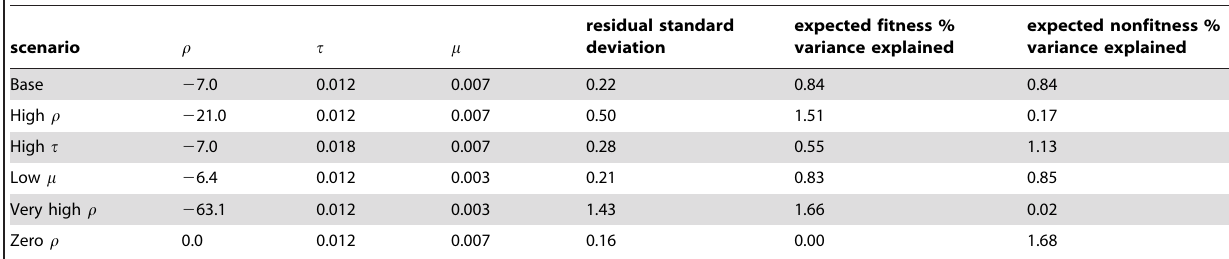
Table 3. Simulation